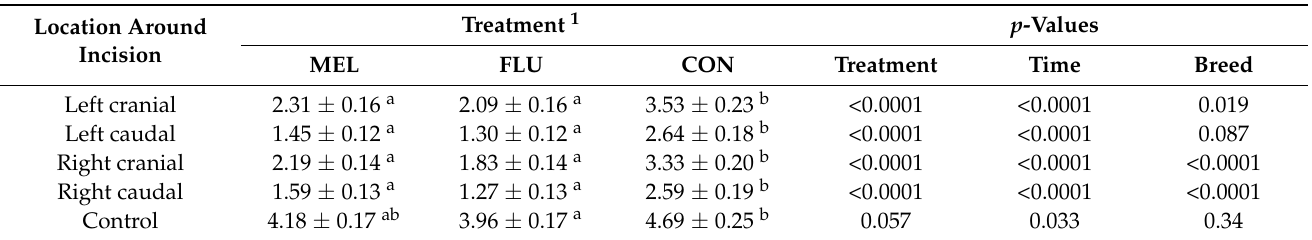
Table 4. Mean mechanical nociceptive threshold (kgf ± SEM) at the four test sites around the abdominal incision and at the control site on the upper abdomen for each treatment group ( n = 12 sheep per analgesia group; n = 6 controls). For controls, these sites were estimated based on where the incision would have been made.